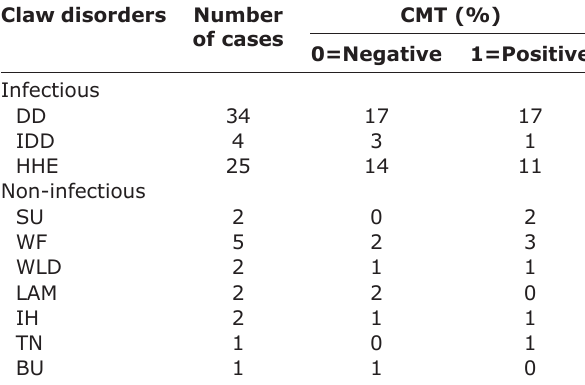
Table-3: Infectious and non-infectious claw disorders and the corresponding CMT results as an indicator for subclinical IMIs in Egyptian dairy